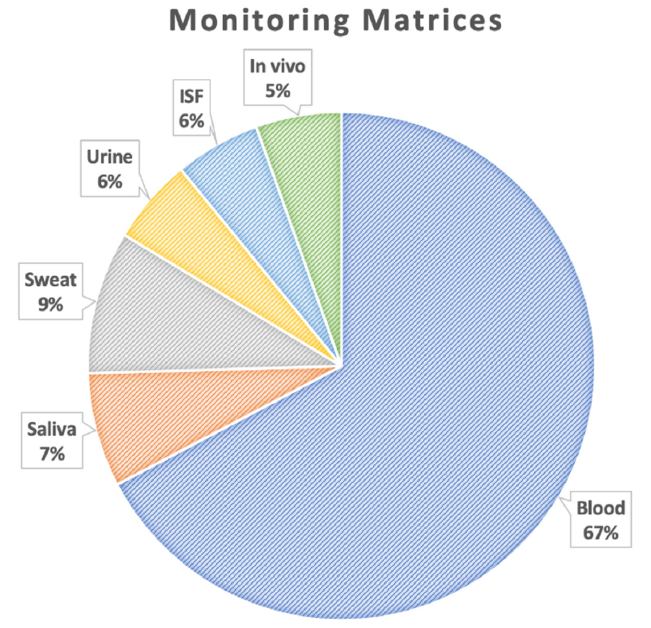
Figure 3. Percentage of studies monitoring lithium in each matrix including blood, saliva, sweat, urine, interstitial fluid (ISF), or in vivo.